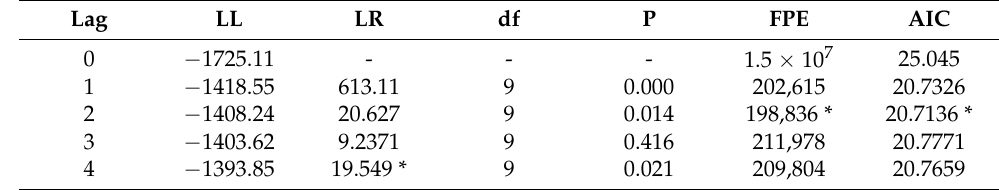
Table 9. Optimal lag length concerning the coal consumption rate of fossil power